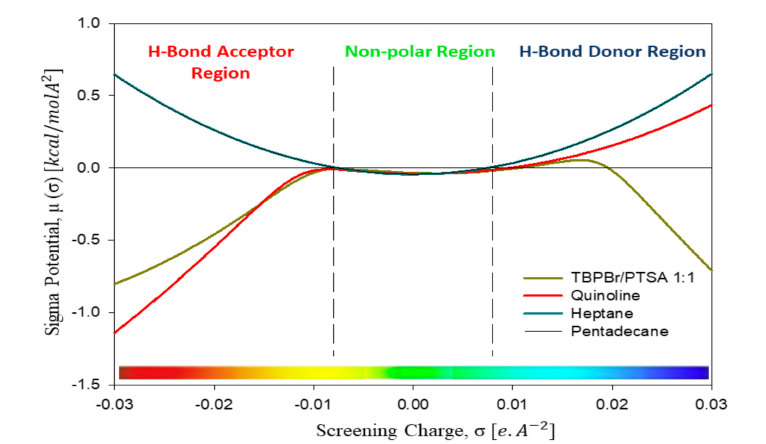
Figure 4. Sigma potential of all species in the heptane system and the pentadecane system. The region between − 0.008 eA − 2 < σ < + 0.008 eA − 2 indicates the London dispersion force in heptane. Peaks at σ hb > + 0.008eA − 2 indicate hydrogen bonding energy and the presence of a hydrogen bond donor, while peaks at σ hb < + 0.008eA − 2 indicate the presence of a hydrogen bond acceptor group.